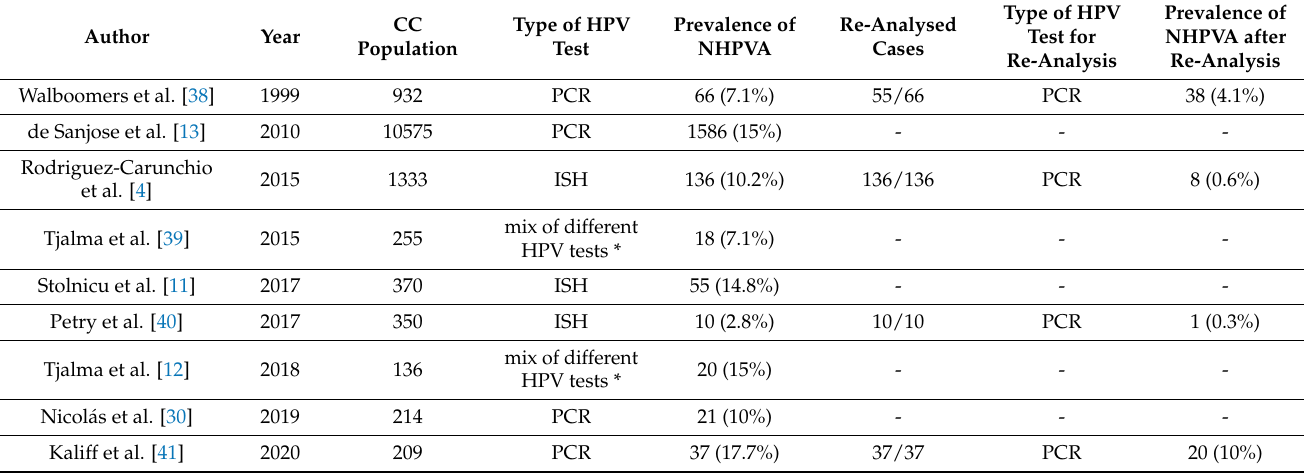
Table 4. Prevalence of non-human papillomavirus-associated adenocarcinoma in the reviewed studies.